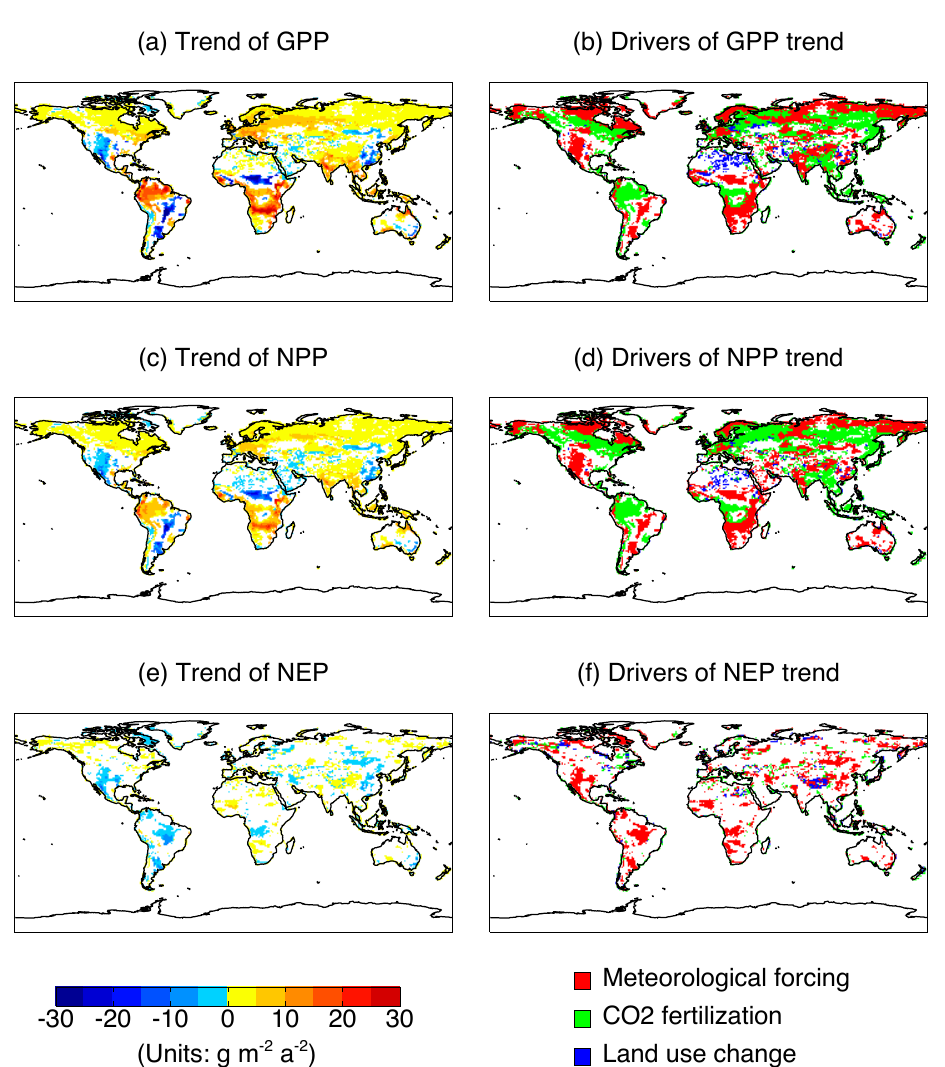
Figure 2. Simulated trends in (a) gross primary productivity (GPP), (c) net primary productivity (NPP), and (e) net ecosystem productivity (NEP), and (b, d, f) the dominant drivers for these changes during 1982–2011. Simulations are performed with WFDEI reanalysis. Three factors, meteorological forcing, CO 2 fertilization, and land use change, are considered as the potential drivers of flux trends. For each grid in figures (b, d, f) , the factor generating the largest (either maximum or minimum) trend with the same sign as the net change (a, c, e) is selected as the driving factor. Only significant trends ( p < 0 . 05) are